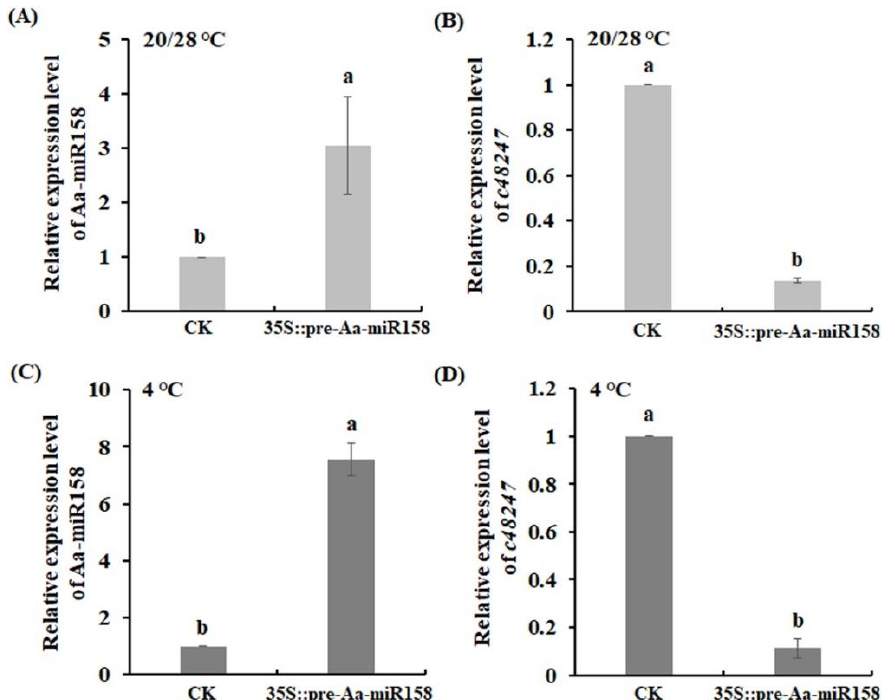
Figure 4. Transient overexpression assay of pre-Aa-miR158 in A. andraeanum leaves. ( A ) Aa-miR158 expression at 20/28 ◦ C; ( B ) c48247 expression at 20/28 ◦ C; ( C ) Aa-miR158 expression at 4 ◦ C; ( D ) c48247 expression at 4 ◦ C. Error bars represent standard deviations ( n = 3). Within each graph, values marked with the different letter are significantly different ( p < 0.05, Student’s t -test).